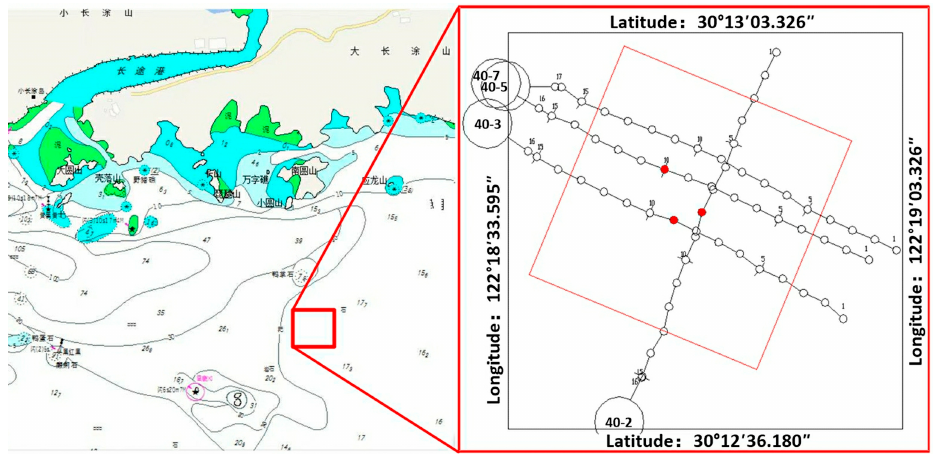
Figure 14. AUV offshore deployment.